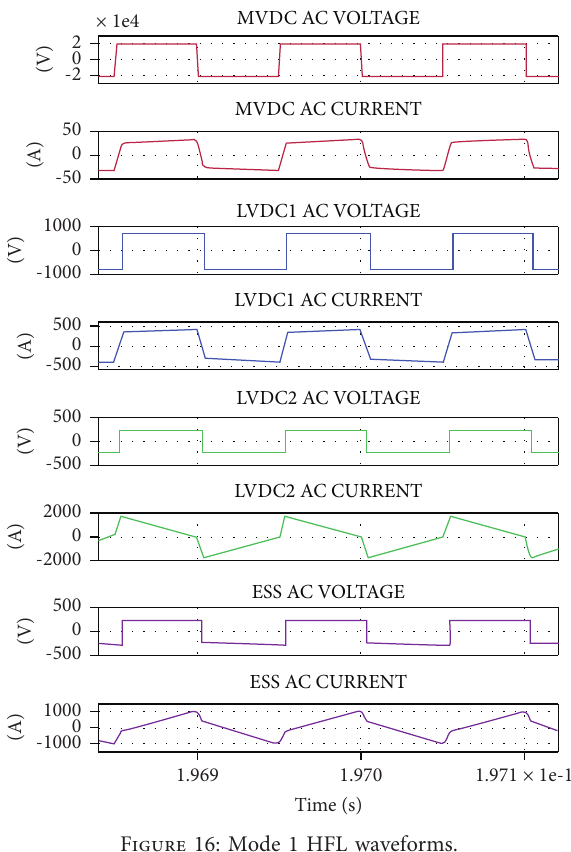
Figure 16: Mode 1 HFL waveforms.